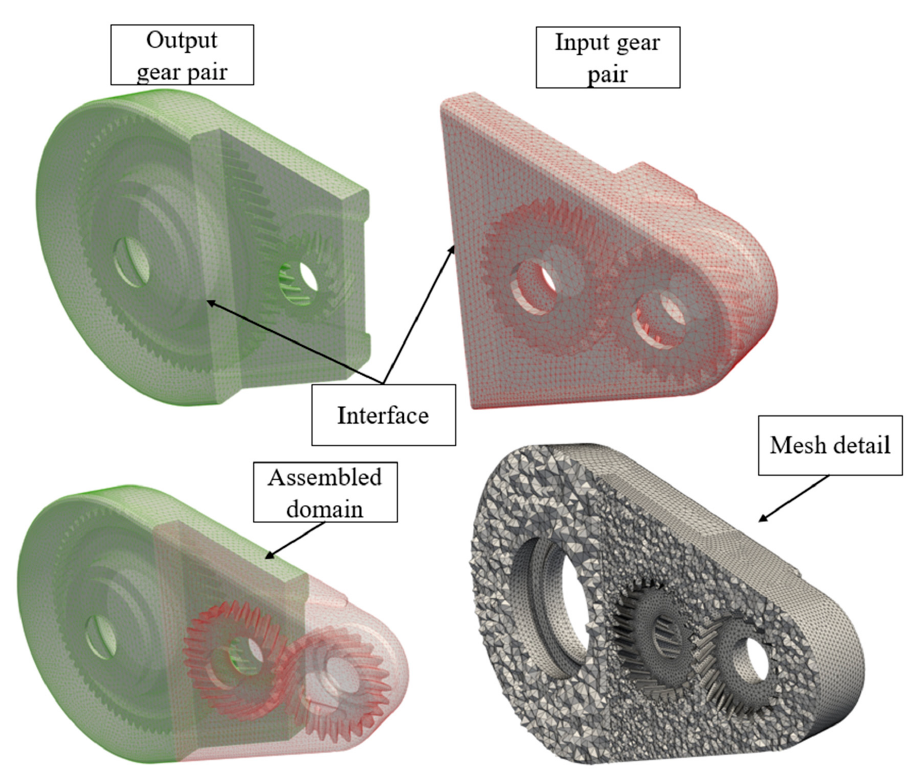
Figure 2. Domain decomposition: assembly of the two partitions and detail of the mesh on a section plane.